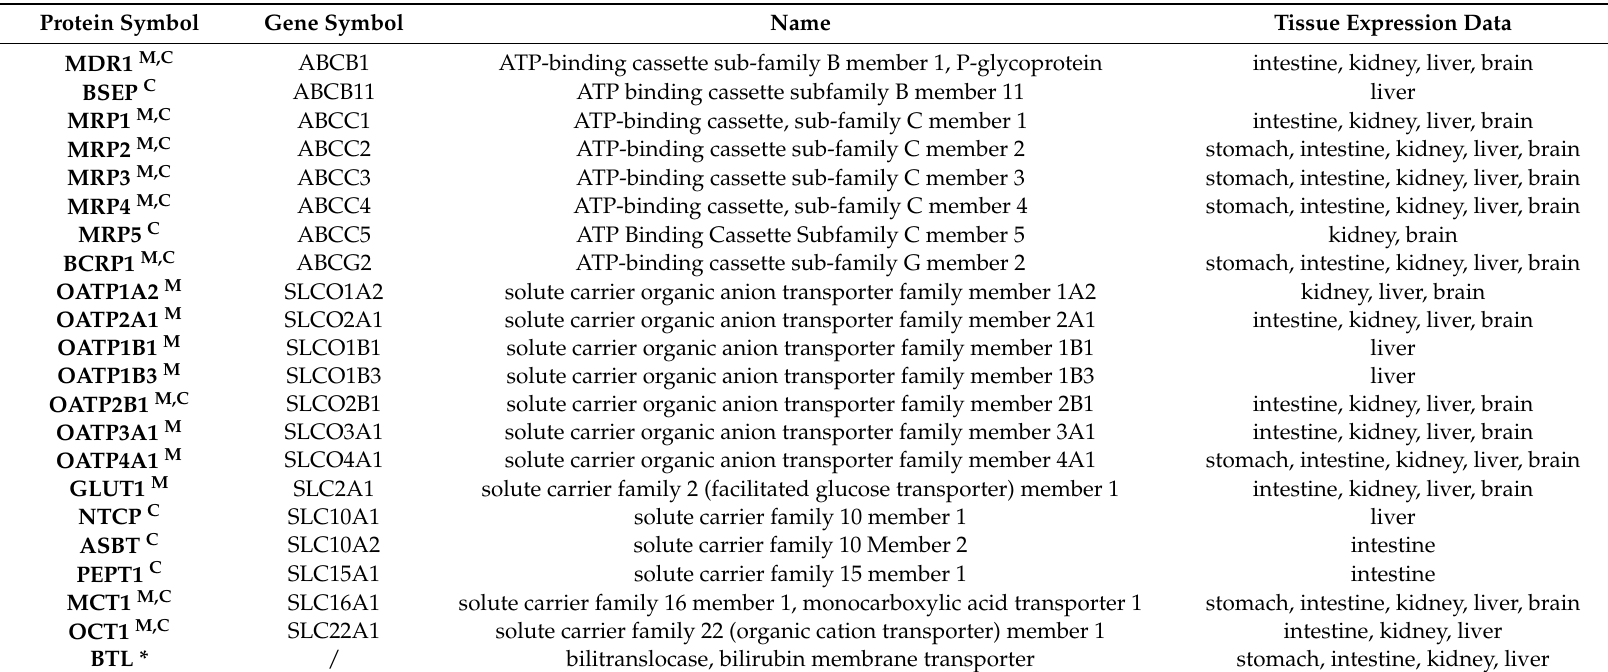
Table 3. List of transporters from Metrabase and ChemBench